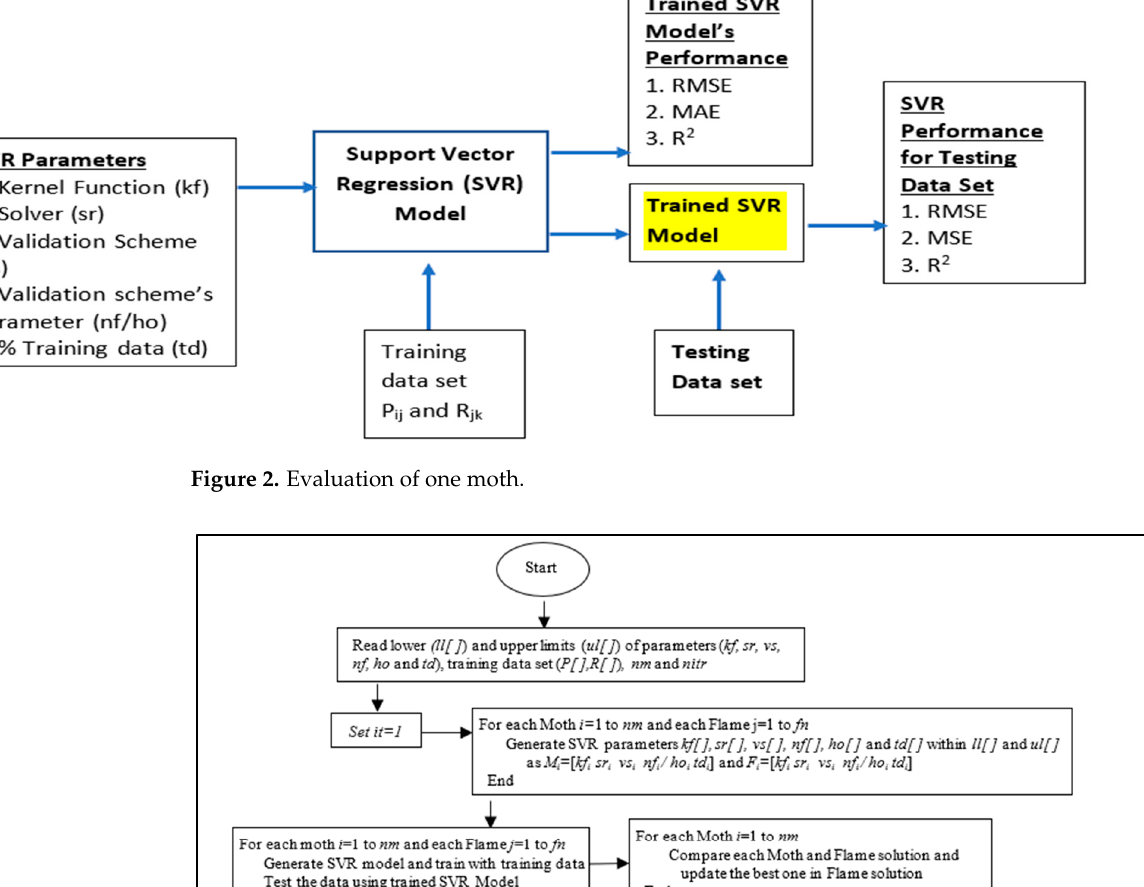
8 of 28 Table 3. Moth’s representation. Kernel Function 20 Table 4. Lower and upper bound value of SVR parameters.